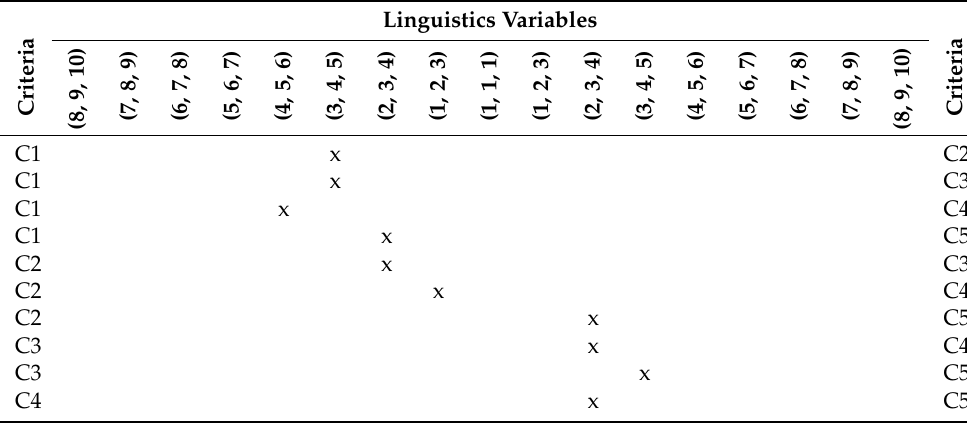
Table 5. The initial comparison matrix of FAHP model.